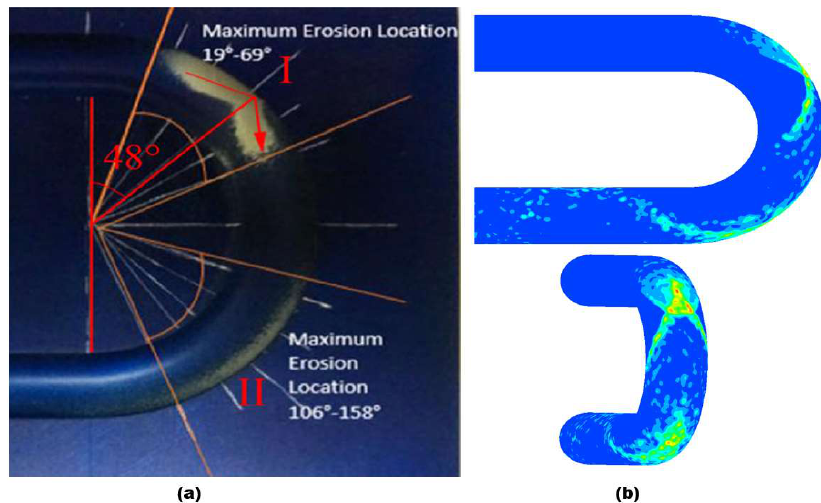
Figure 4. Comparison of the erosion location: ( a ) experimental results in Mazumder [21]; ( b ) numer- ical results (present study).